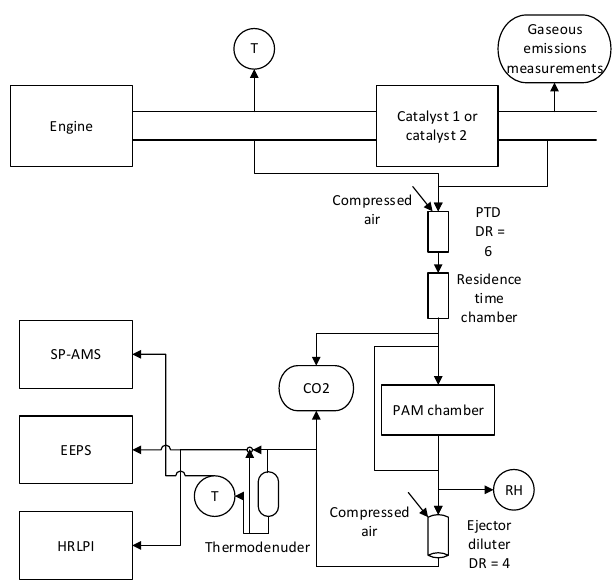
Figure 1. A schematic picture of the measurement setup.